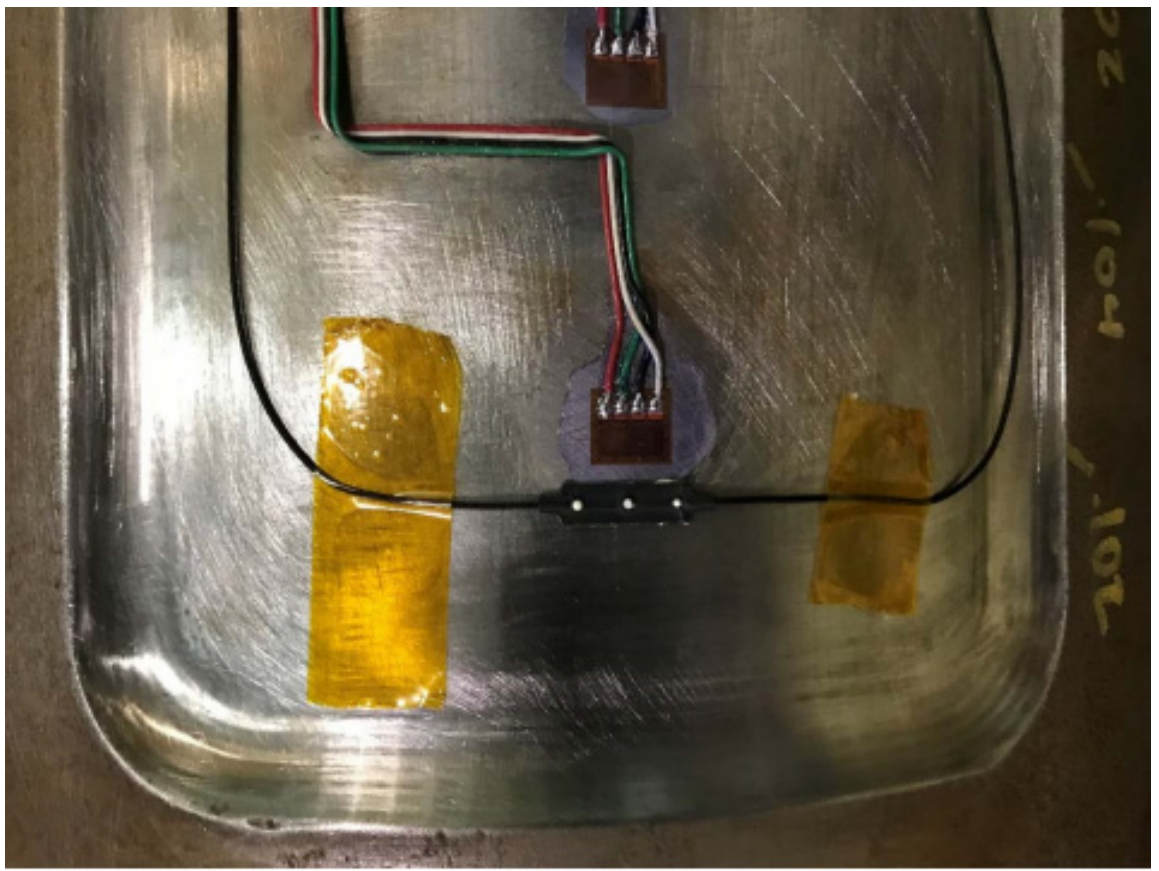
Figure 15 . Application of fiber optic sensor with an optical strain gauge in the corroded part of a pipe (Reprinted/adapted with permission from Dr. Chris Alexander; Source: Ref. [63]. Copyright